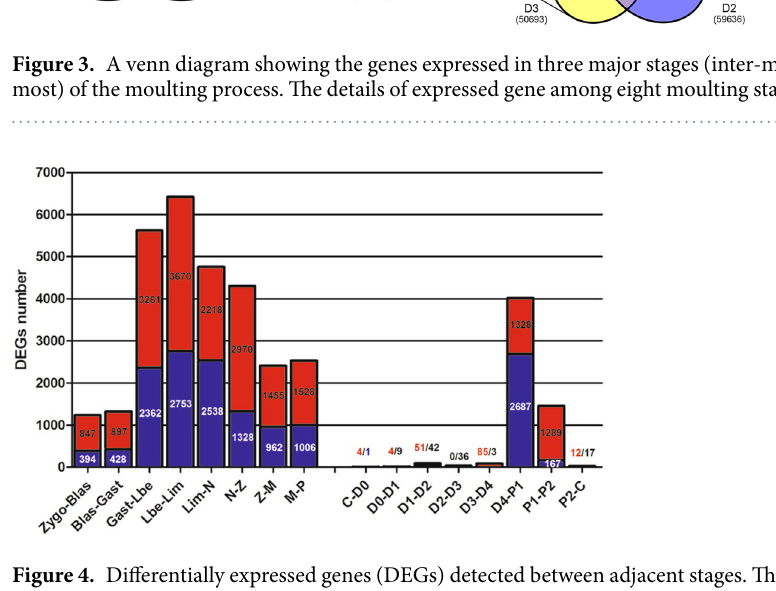
Figure 4. Differentially expressed genes (DEGs) detected between adjacent stages. The numbers of up- regulated and down-regulated genes are revealed by red and blue,